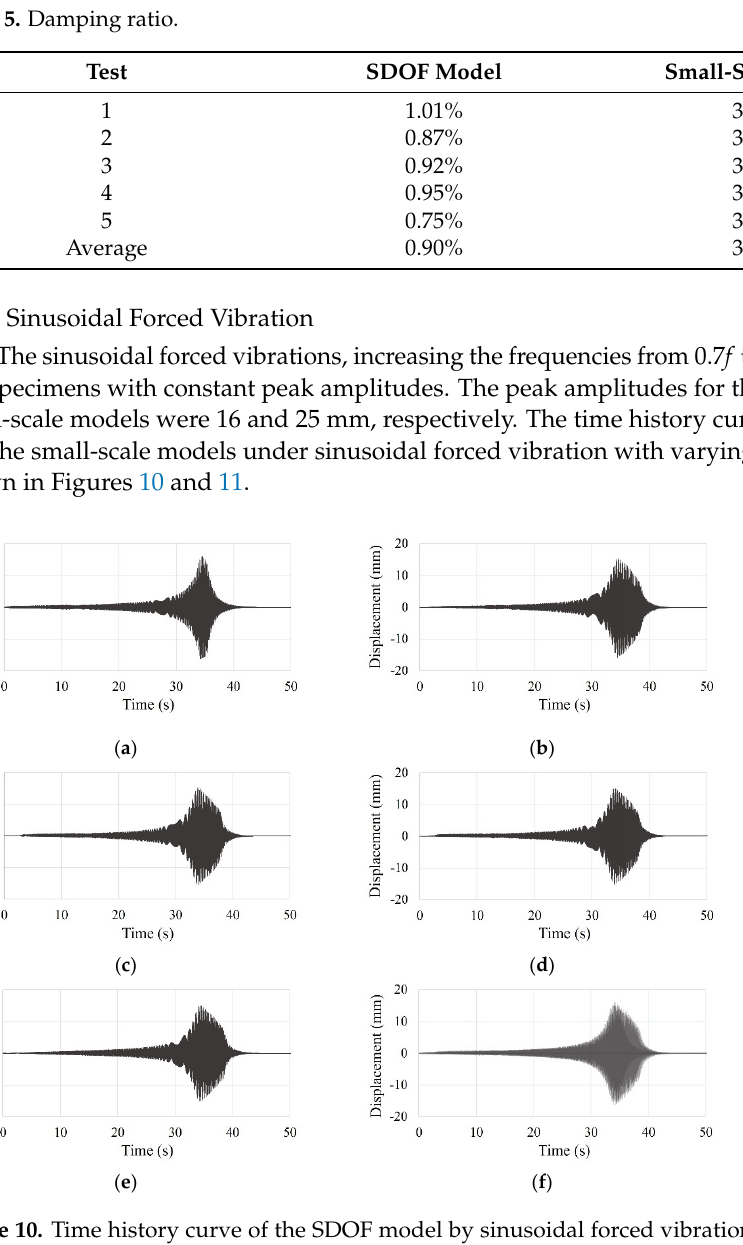
Figure 9. Example of time history curve of the free vibration. Based on the method, damping ratios of the SDOF and small-scale models under free vibrations are presented in Table 5. The average damping ratios of the SDOF and the small-scale models were 0.90% and 3.30%, respectively.